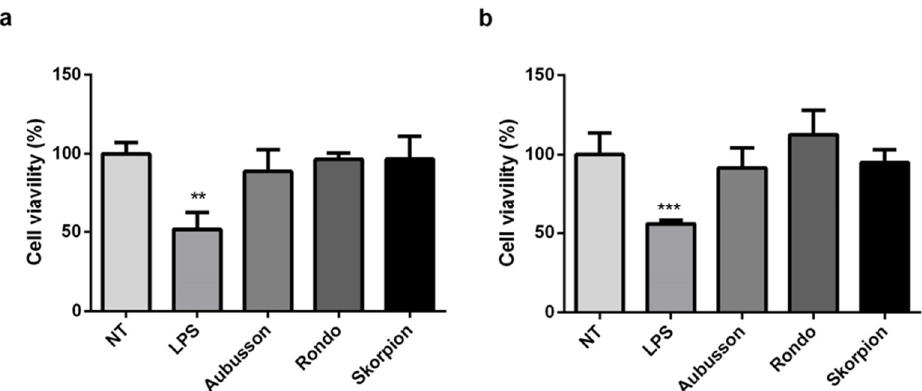
Figure 2. Effects of LMW peptides from doughs ( a ) and breads ( b ) on cell viability. RAW 264.7 were incubated with LMW peptides (0.05 mg/mL) or LPS for 24 h. After this time, cell viability was evaluated using the MTT test. The absorbance of formazan was determined at 595 nm. NT: negative control, untreated cells; LPS: positive control, cells treated with the only LPS; Aubusson, Rondo, and Skorpion indicate cells treated with LMW peptides obtained from doughs and breads prepared with the respective flours. Data reported in the figure represent the mean ( ± SD) of three different experiments performed in duplicate. Statistical analysis was performed for each sample vs. LPS (** p < 0.01; *** p < 0.001)